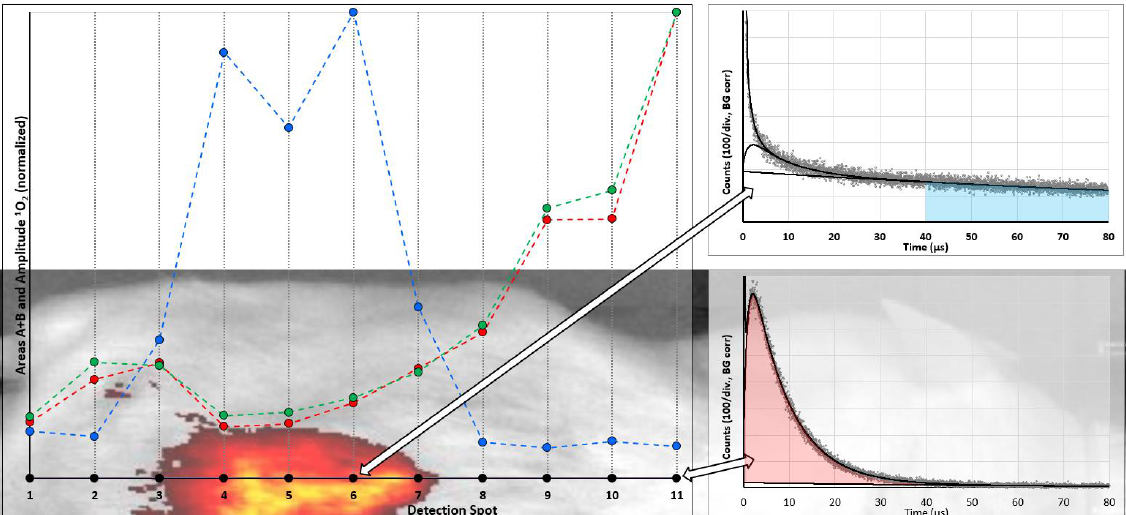
Figure 4. Results of measurements at 11 spots (black dots) along a line across the mouse skin, crossing the tumor. The overlay with the fluorescence image of the mouse indicates the exact locations. PS phosphorescence intensity was determined by summing up the signal in the range of 40–80 µs after laser pulse, corrected for background (blue). Relative 1 O 2 intensity is shown for two ways to analyze the data: the amplitude of the 1 O 2 component determined by fitting of the kinetics (green) and robust data analysis as explained in the text (red). For detection spots 6 and 11 the determined phosphorescence kinetics are shown on the right (indicated by the arrows), where red and blue areas are again the graphical representation of the values determined by the robust data analysis.